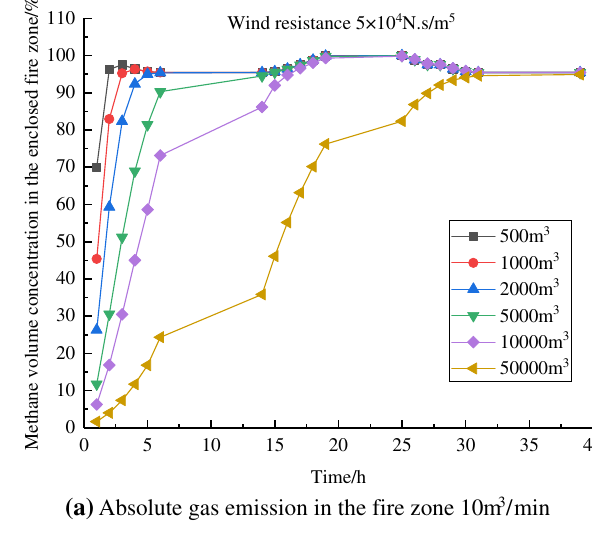
(a) Absolute gas emission in the fire zone 10m 3 /min